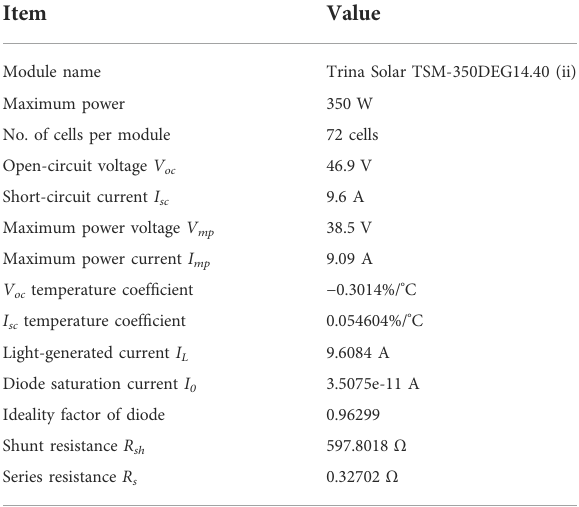
TABLE 2 PV module datasheet.